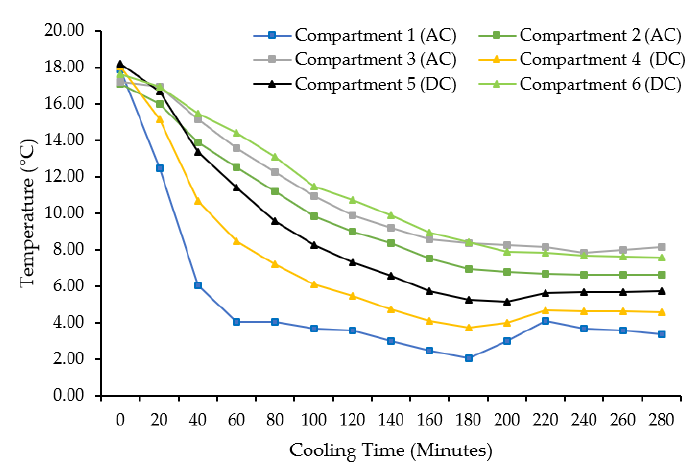
Figure 5. Temperature changes in individual compartments (with natural and forced air circulation).